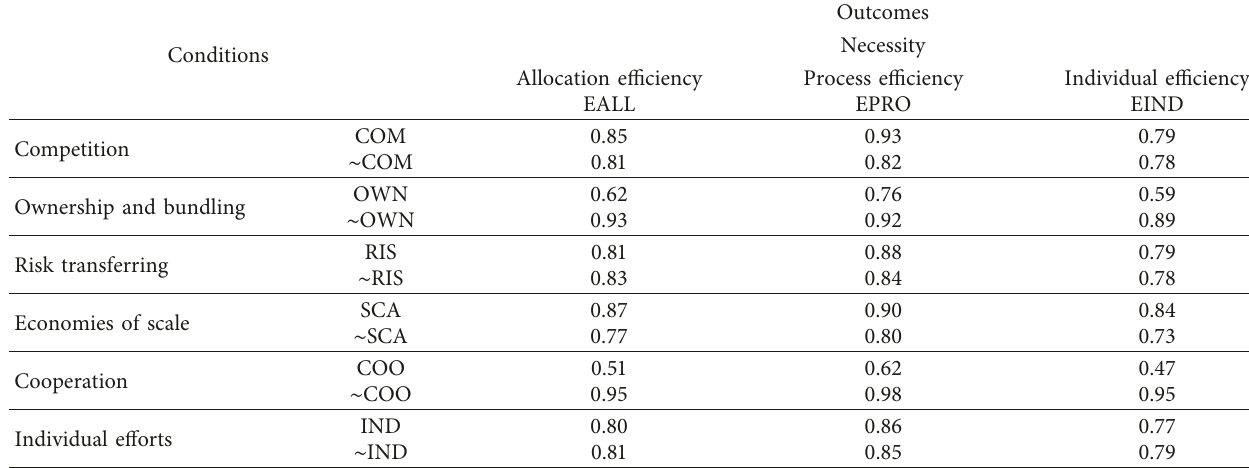
Table 5: The necessity of single preconditions.